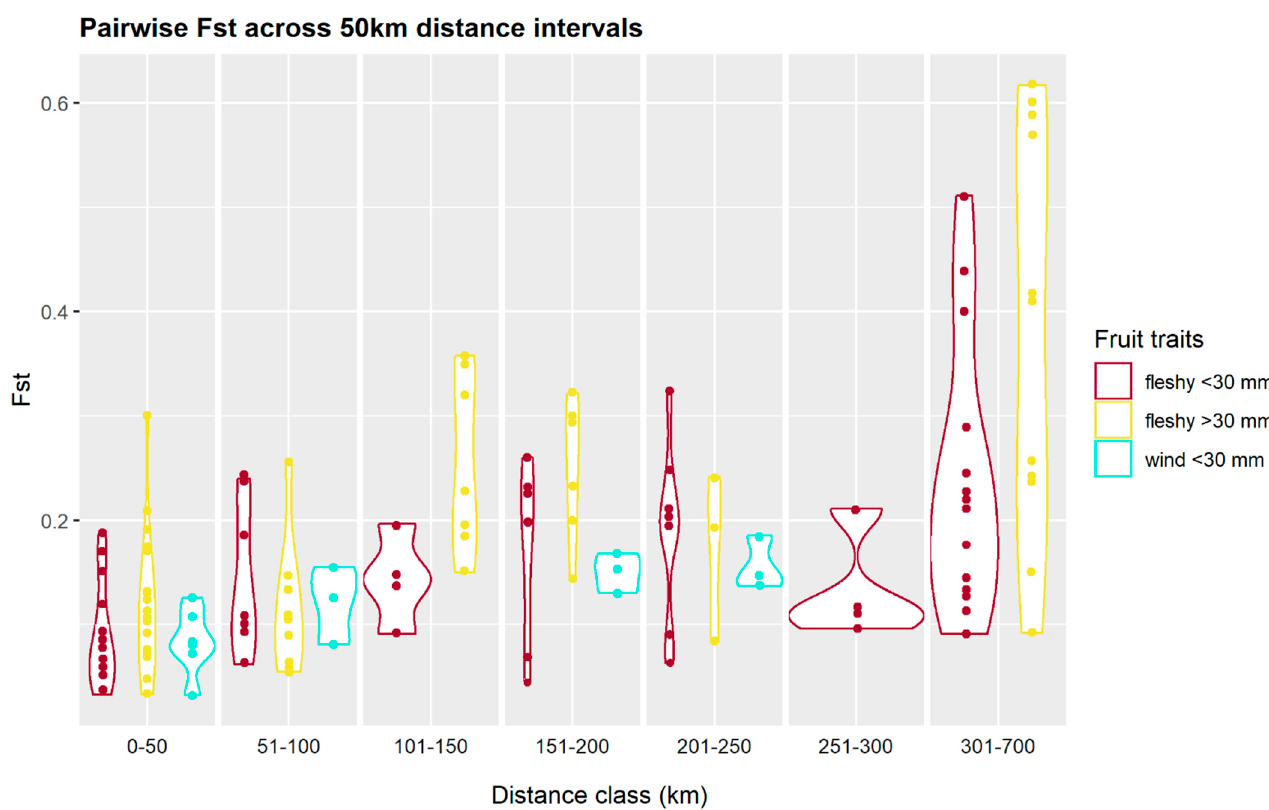
Figure 2. Violin plots of the average pairwise Fst values calculated for 25 species at 50 km distance intervals and coloured by fruit trait.